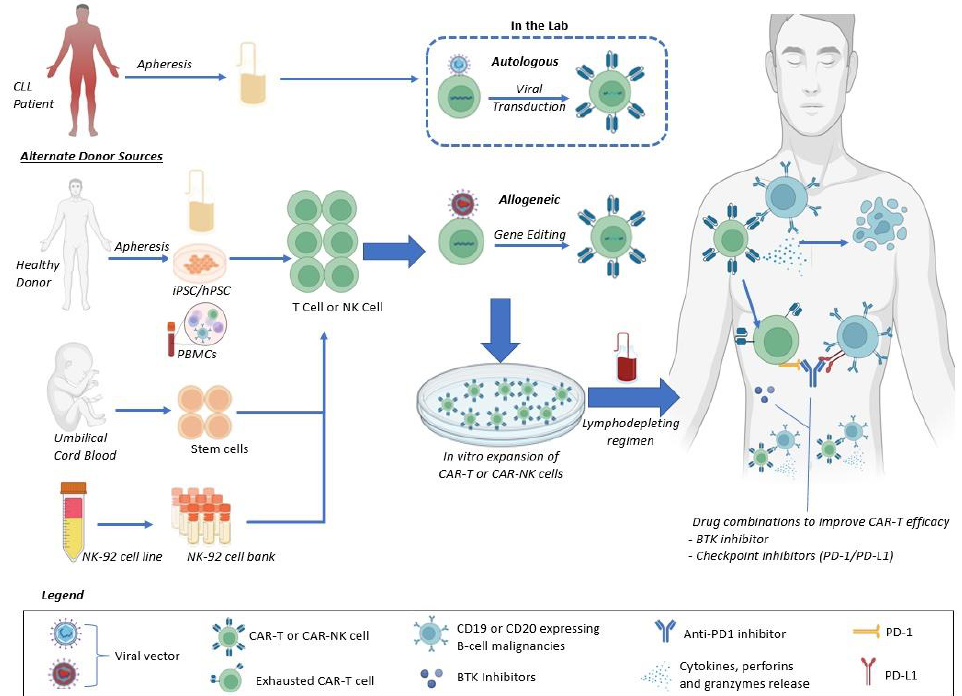
Figure 2. Schematic for CAR products with emphasis on emerging techniques to improve safety and efficacy in CLL patients. Allogeneic NK sources can include peripheral blood mononuclear cells (PBMCs), induced pluripotent stem cells (iPSC), human pluripotent stem cells (hPSC), NK cell lines, and umbilical cord blood. Allogeneic T-cell sources can include peripheral blood apheresis samples, iPSC/hPSC, and umblical cord blood.